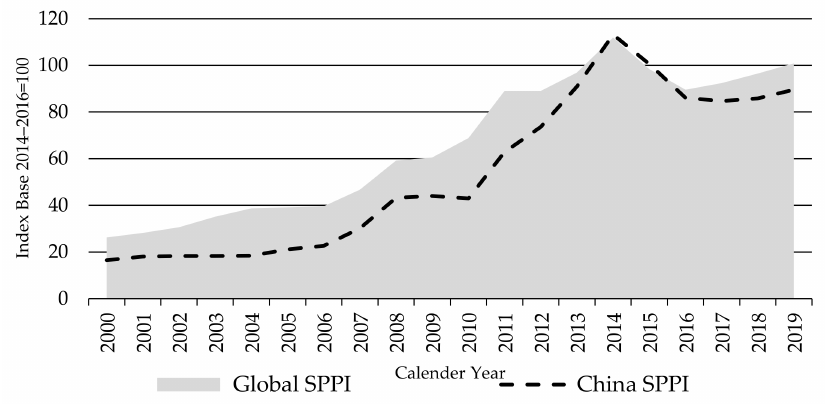
Figure 12. The Global and China Sheep Meat Producer Price Indices SPPIs, source: own